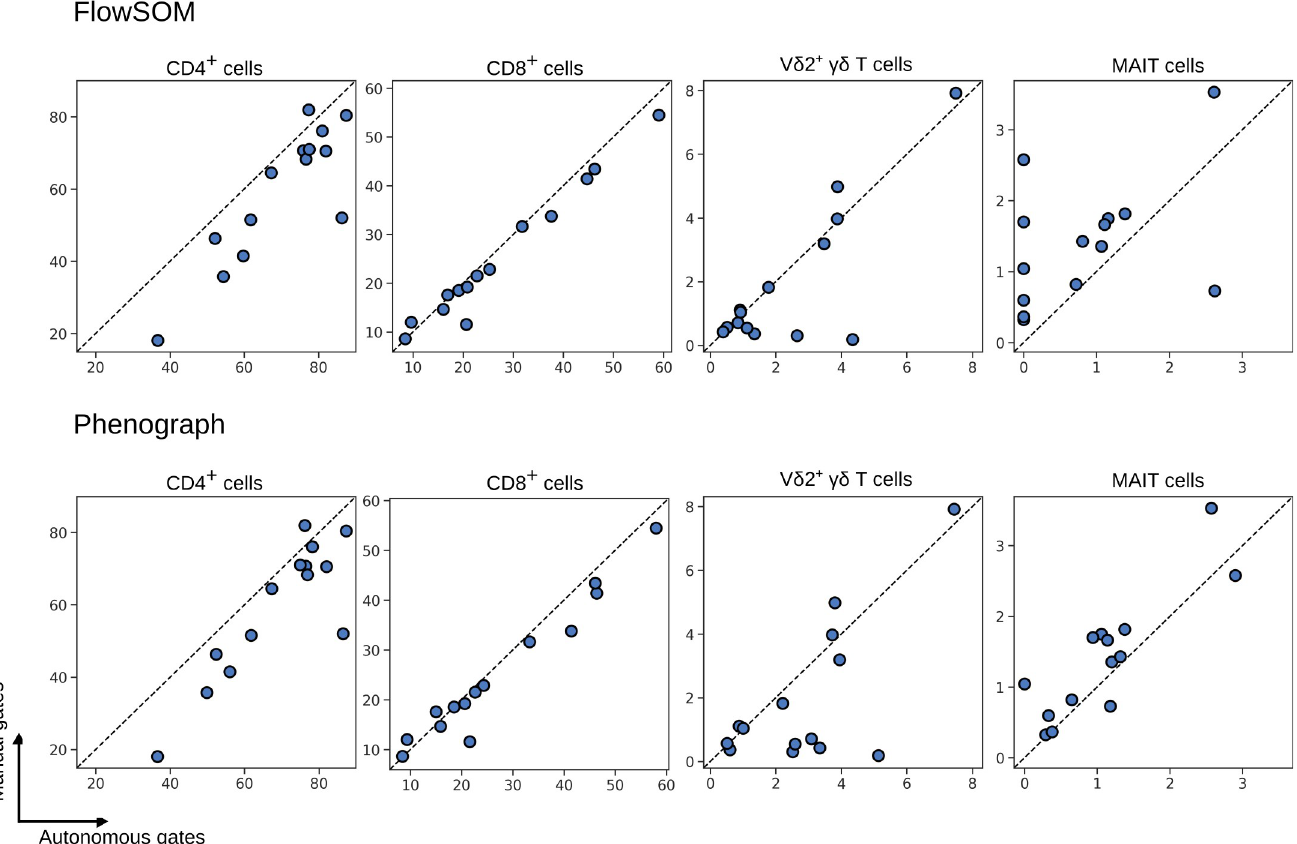
Fig 7. Percentage of T cell subsets as identified by FlowSOM (top) and Phenograph clustering (bottom), compared to the same subsets as identified by expert manual gates. Each symbol depicts results obtained with cells from an individual